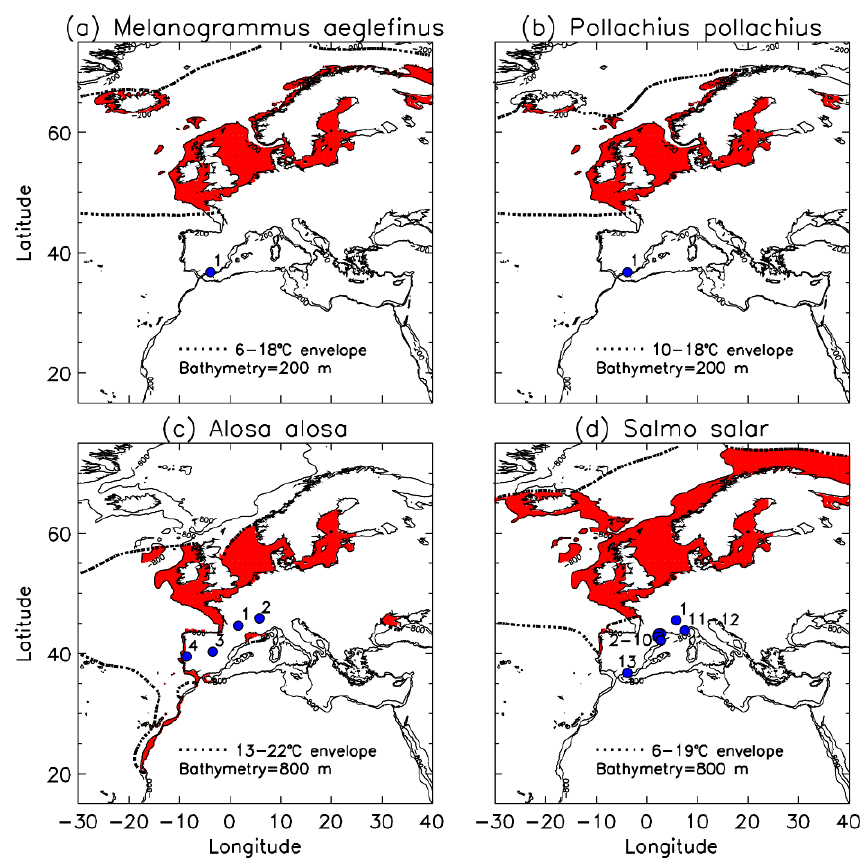
Fig. 3. Simplified species ranges using simplified criteria based on the summer SST and bathymetry envelopes shown in each diagram. The archaeozoological finds are given by blue dots with the number key given in Table 1. For (a) and (b) , the archaeological site is 1. Cueva de Nerja, Spain. For (c) , the archaeological sites are 1. P´egouri´e, Atlantic France, 2. Sous Balme, Mediterranean France, 3. Aridos-1, Spain, and 4. Lapa dos Coelhos, Portugal. For (d) , the archaeological sites are 1. Grotte Jean-Pierre I, Mediterranean France, 11. Baouss´e-Rouss´e, Grottes de Menton, Italy, 12. Barme Grande, Grimaldi caves, Italy, 13. Cueva de Nerja, Spain, and a cluster of different sites along the Mediterranean coast of France and Catalonia with labels 2–10. The bathymetry is from ETOPO-5 with sea level and the single additional bathymetric contour indicated on the maps.